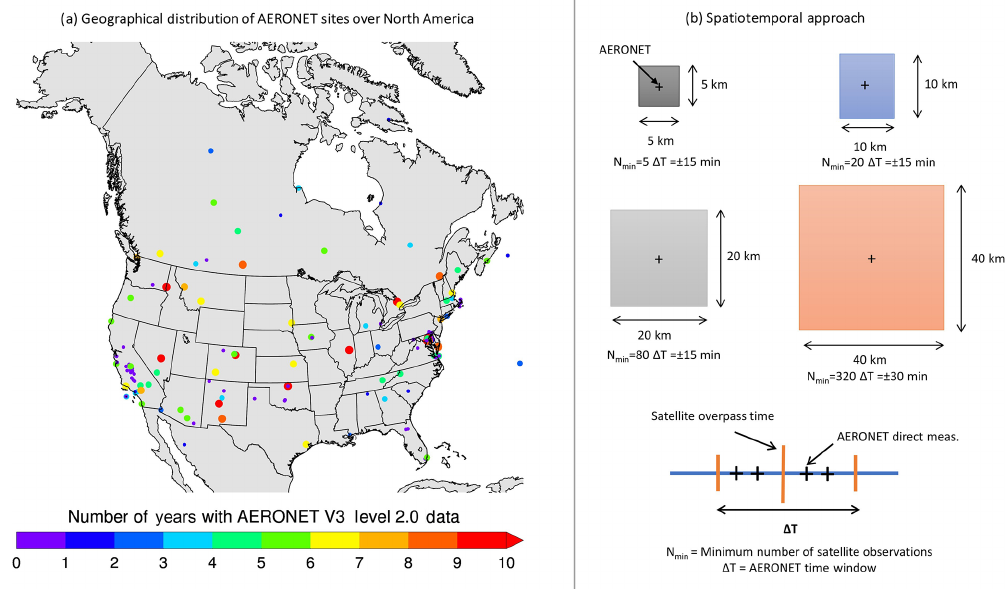
Figure 1. (a) Geographical distribution of AERONET sites over North America. Color codes represent the span of AERONET Version 3 Level 2 data calculated from the daily dataset. (b) An illustration of the spatiotemporal schemes for collocating the satellite retrievals with the ground measurements. Table 2. Configurations of four spatiotemporal windows for the collocation of MODIS and AERONET AOT datasets. Acronyms are as follows. DT: Dark Target; DB: Deep Blue; MAIAC: Multi-Angle Implementation of Atmospheric Correction. Grid box Required minimum number of (cid:49)T : time window Minimum number of size satellite observations at 1km between the satellite AERONET Level 2 (km 2 ) in the grid box overpass and observations AERONET within (cid:49)T measurements DT 10km DT 3km DB MAIAC